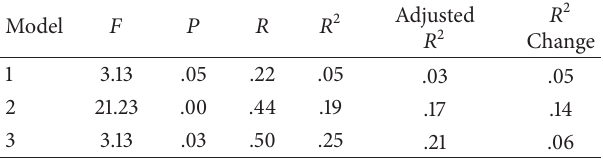
Table 6: Results of regression analysis for additional contributions ofdepthofvocabularyknowledgewhenvocabularysize,motivation, and self-efficacy were controlled ( 𝑁 =